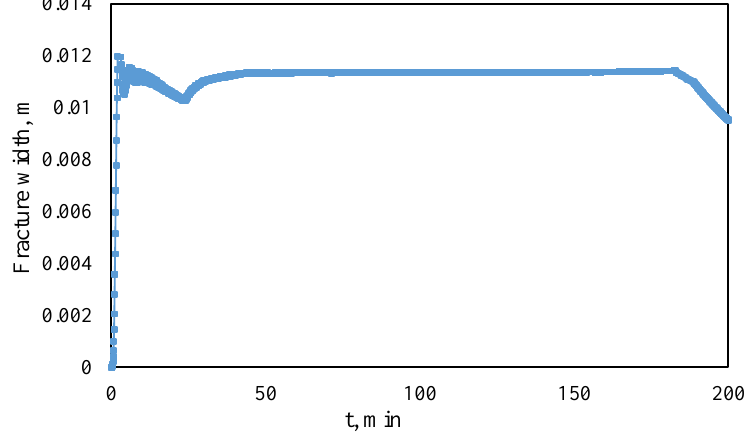
Figure 6--Predicted fracture width for single fracture of Well A during fracture